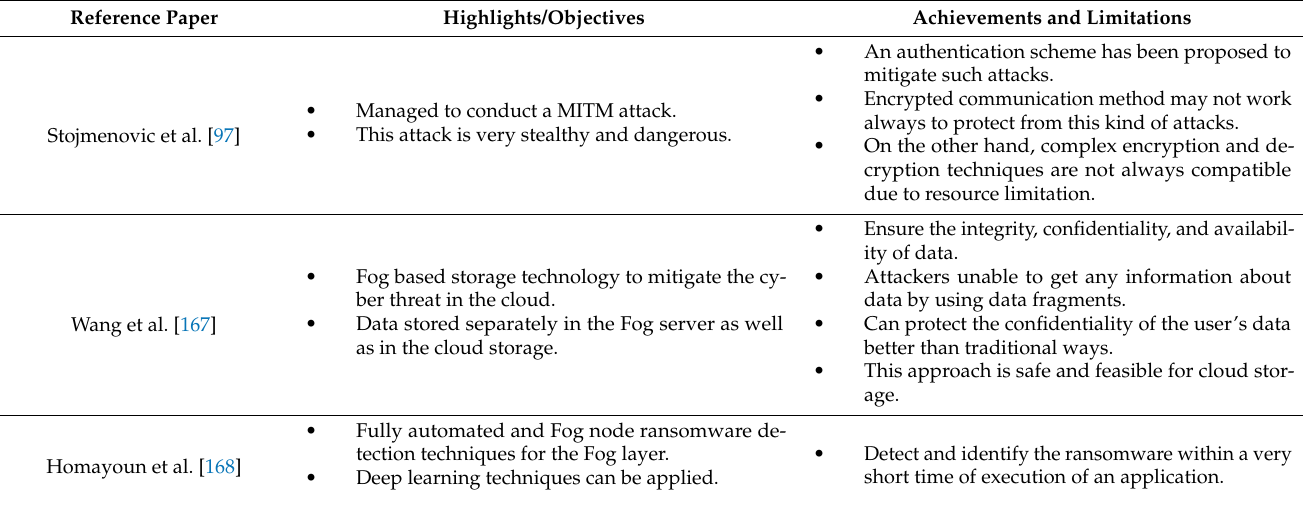
Table 10. The summary of threats and attacks issues in Fog environments from major survey